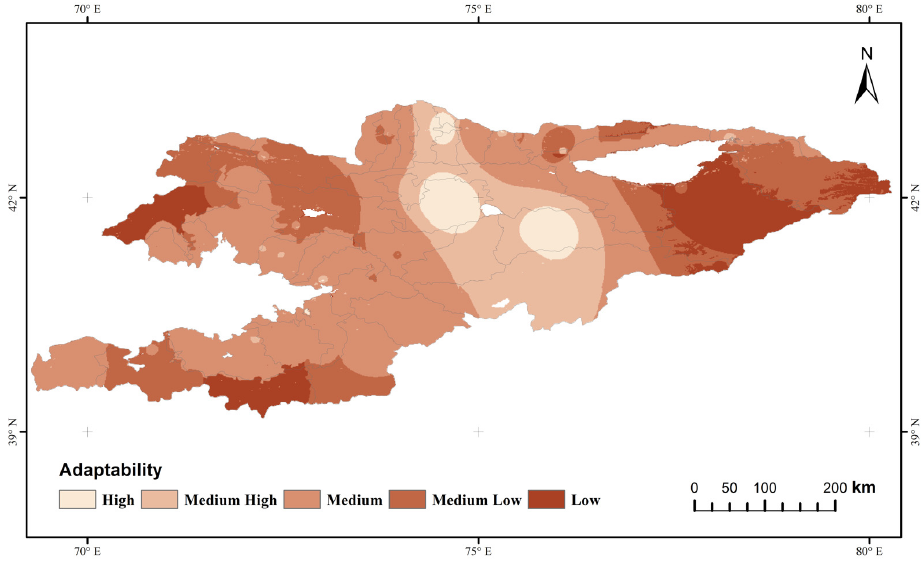
Figure 3. Spatial distribution of agricultural system adaptation in Kyrgyzstan.